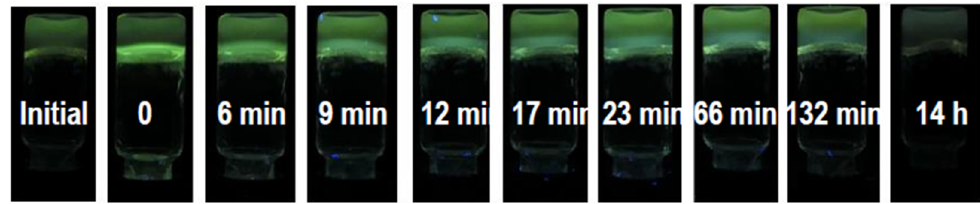
Figure 12. From left to right: (1) reference 1 (1.68 × 10 − 5 M in DMSO); (2) reference + air (bubbled); (3) reference + fish sample (bubbled) (3 days at 25 °C); (4) reference + fish sample (bubbled) (1 day at 25 °C); (5) reference + histamine (bubbled); (6) reference + putrescine (bubbled); (7) reference + (Top) Under visible light; (Bottom) under UV light (366 nm).